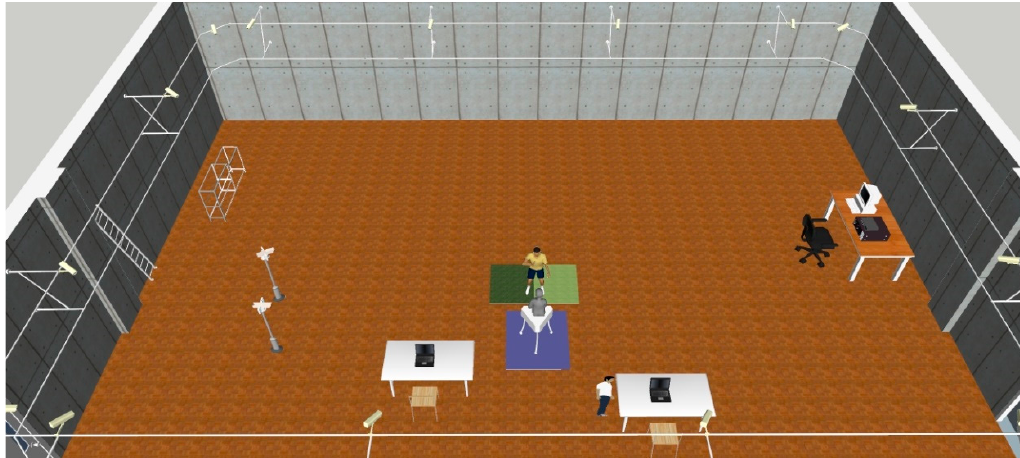
Figure 4. The 3D renderings of the experimental site and equipment installation location.